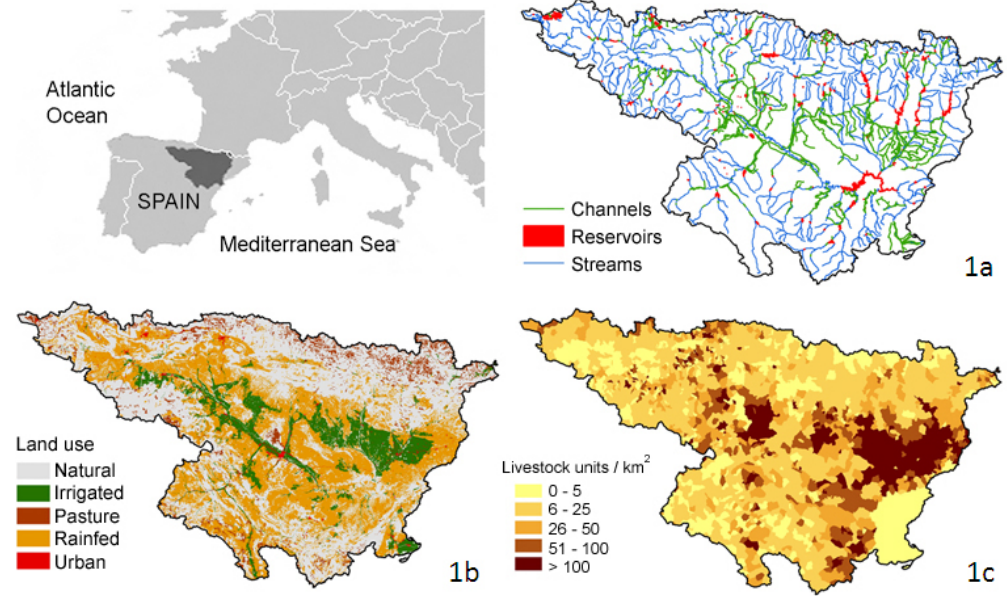
Fig. 1. Study area (a) river network, channels and reservoirs; (b) land use; (c) livestock density.